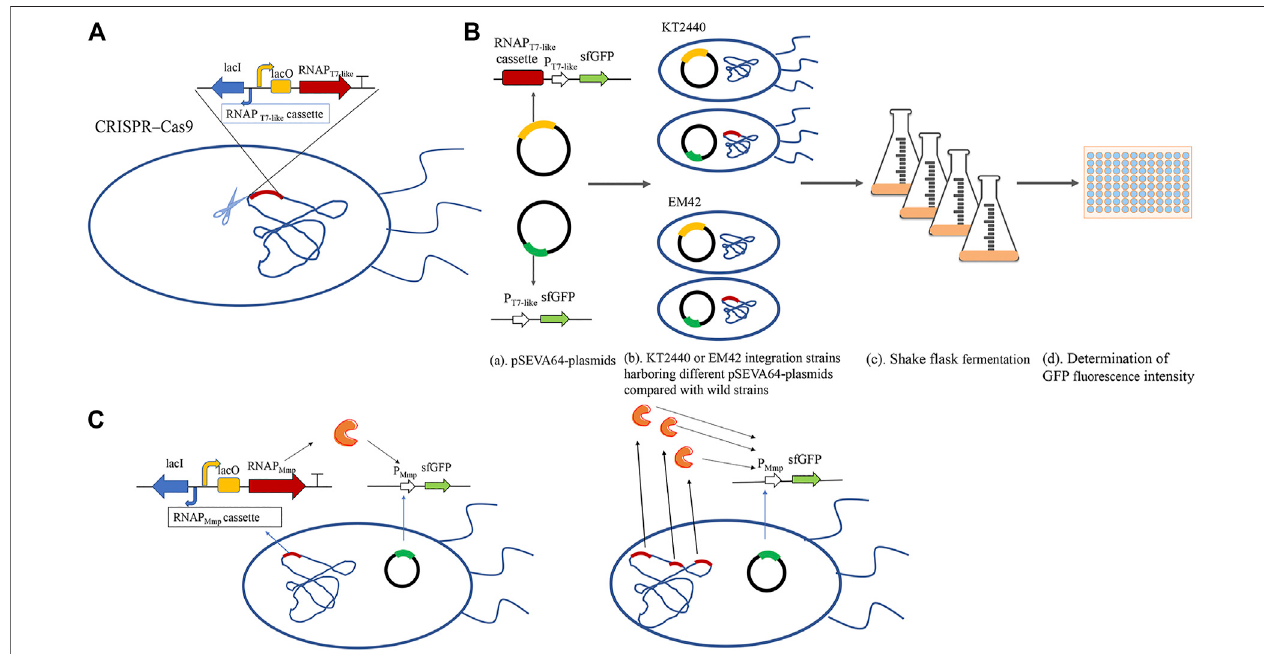
FIGURE 1 | The schematic diagram of the MmP1 expression system constructed in P. putida . (A) Construction of integrated strain by integrating the RNAP cassette into nonessential gene of the genome in P. putida by CRISPR/Cas9; (B) Flowchart about the fl ask shake fermentation of sfGFP with different RNA polymerase cassette; (a) Construction of veri fi ed plasmids: the upper contains both RNAP cassette and promoter modules; the lower contains only promoter modules; (b) The veri fi ed plasmids were into wild-type strains and RNAP integrated strains, respectively; (c) Shake fl ask experiments were carried out by inoculating with 2% of the seedcultures at30 ° C;(d) Cellswereharvestedanddiluted twotimes.200 μ lofthediluted liquidwasaddedintothe96-wellmicrotiterplatesand measured theabsolute fl uorescence intensity (AFI) and cell density (OD fl uorescence emission at 510 nm. Finally, the 600 ) by microplate reader using the excitation wavelength at 488 nm and relative fl uorescence intensity (RFI) was calculated by the AFI/OD 600 .; (C) Construction of different copy numbers of MmP1 RNAP integrated in the genome of P.